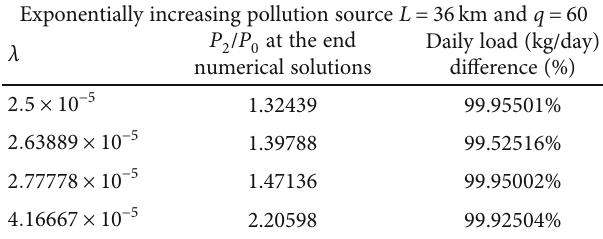
/ P ) at t = 1 day by various arbitrary constants of exponentially increasing pollution source 2 0 Table 2: Various λ of exponentially increasing pollution source for P P concentration and daily load di ff 2/ 0